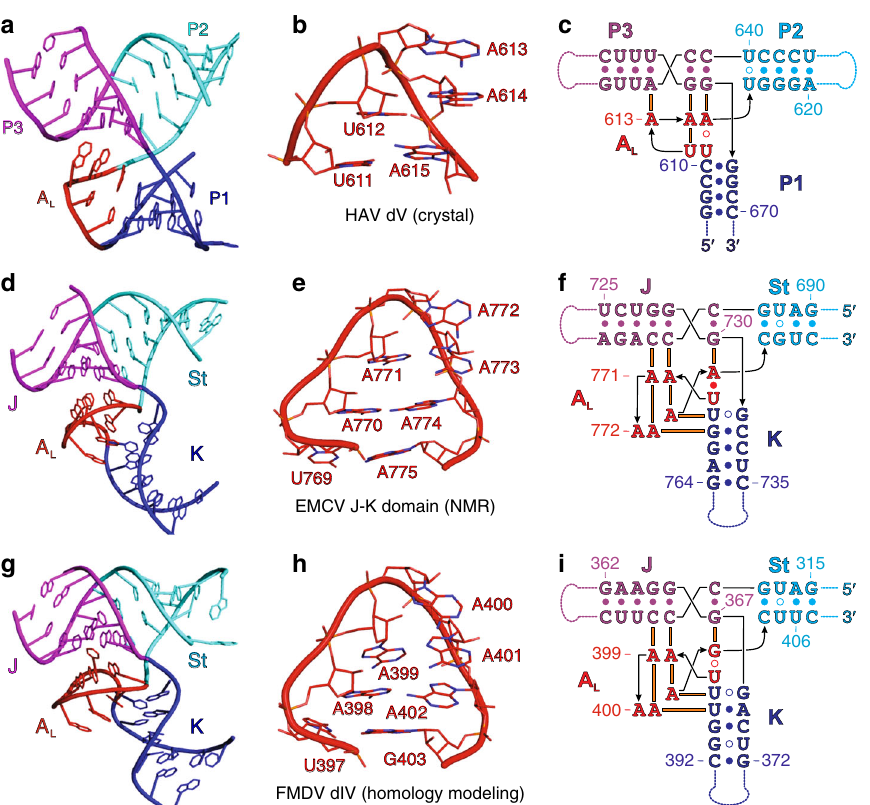
Fig. 5 Comparison of three-way junction structures of analogous RNA domains within picornaviral IRESs. Three-dimensional structure of the three-way junction, corresponding A L motif and overall secondary structure of HAV dV ( a – c ), EMCV J – K domain ( d – f ) and FMDV dIV ( g – i ), respectively. Based on the structural homology with EMCV J – K domain, a model of the FMDV dIV structure was computed in silico using the FARFAR and stepwise Monte Carlo Rosetta protocols 55, 56 . For facile comparison, important structural features and the corresponding nucleotides are colored analogously in all fi gures. Solid and hollow circles depict canonical and non-canonical base-pairing interactions, respectively, and solid orange bars indicate tertiary